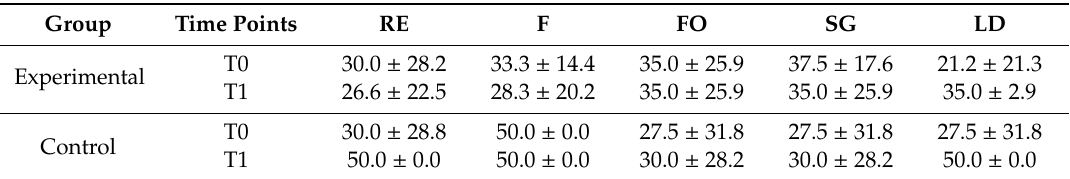
Table 5. Statistical results of the CMF tests at baseline and at the end of the reading sessions ( p > 0.05). Mean ± Standard Deviation is reported.